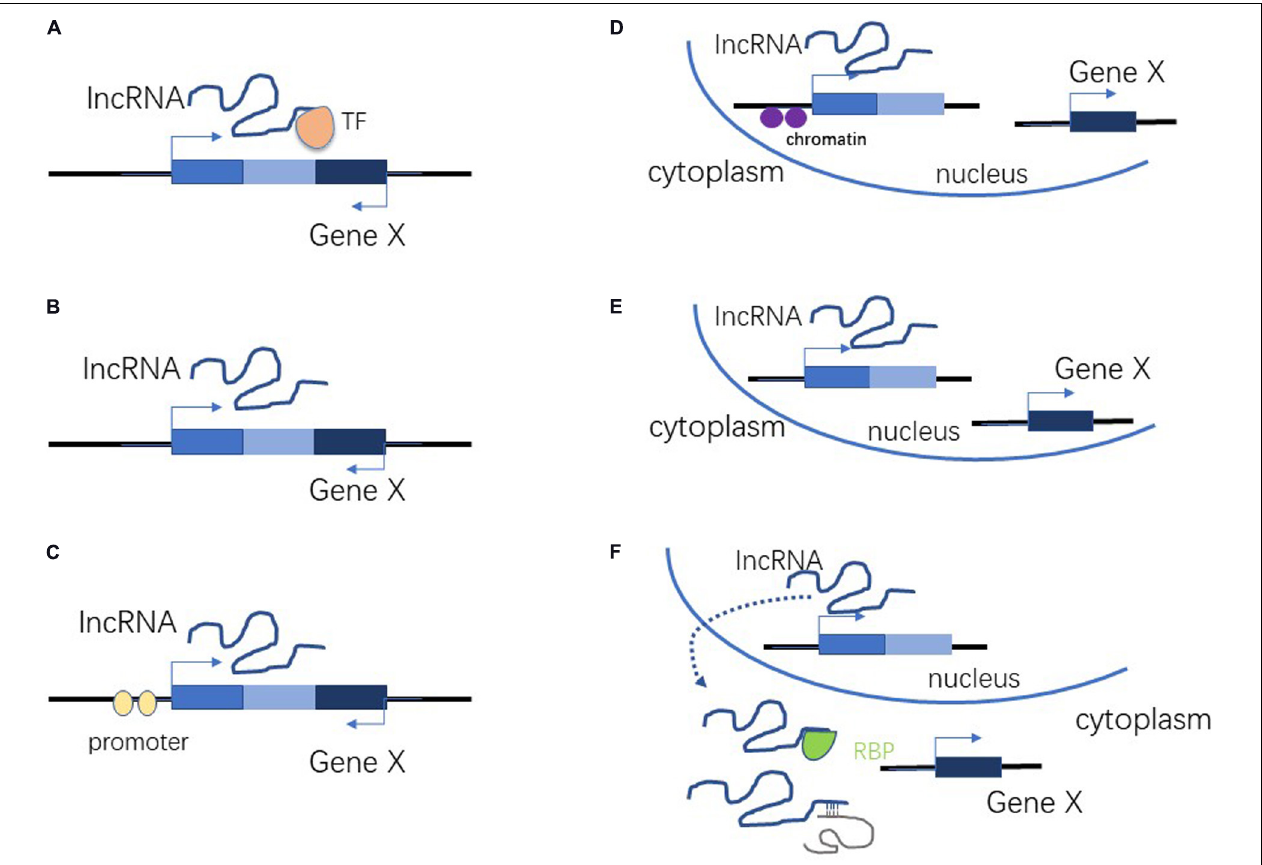
FIGURE 1 | Cis- acting and trans- acting roles of lncRNA. (A) LncRNA recruits transcription factors to a locus to regulate the expression of nearby genes. (B) Regulation of nearby genes during lncRNA transcription and shearing. (C) Regulation of nearby genes by lncRNA promoter or original DNA of the locus. (D) Regulation of chromatin state and gene transcription in distant regions. (E) Regulation of nuclear structure and organization. (F) Binding to proteins or other RNAs to regulate their